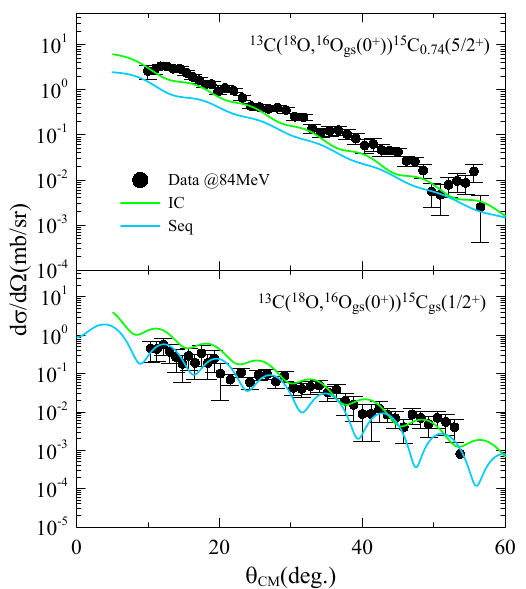
Fig. 1. Comparison of the experimental data and theoretical results corresponding to the 13 C( 18 O, 16 O) 15 C. IC means independent coordinates CRC calculations. Seq stands for the sequential CCBA